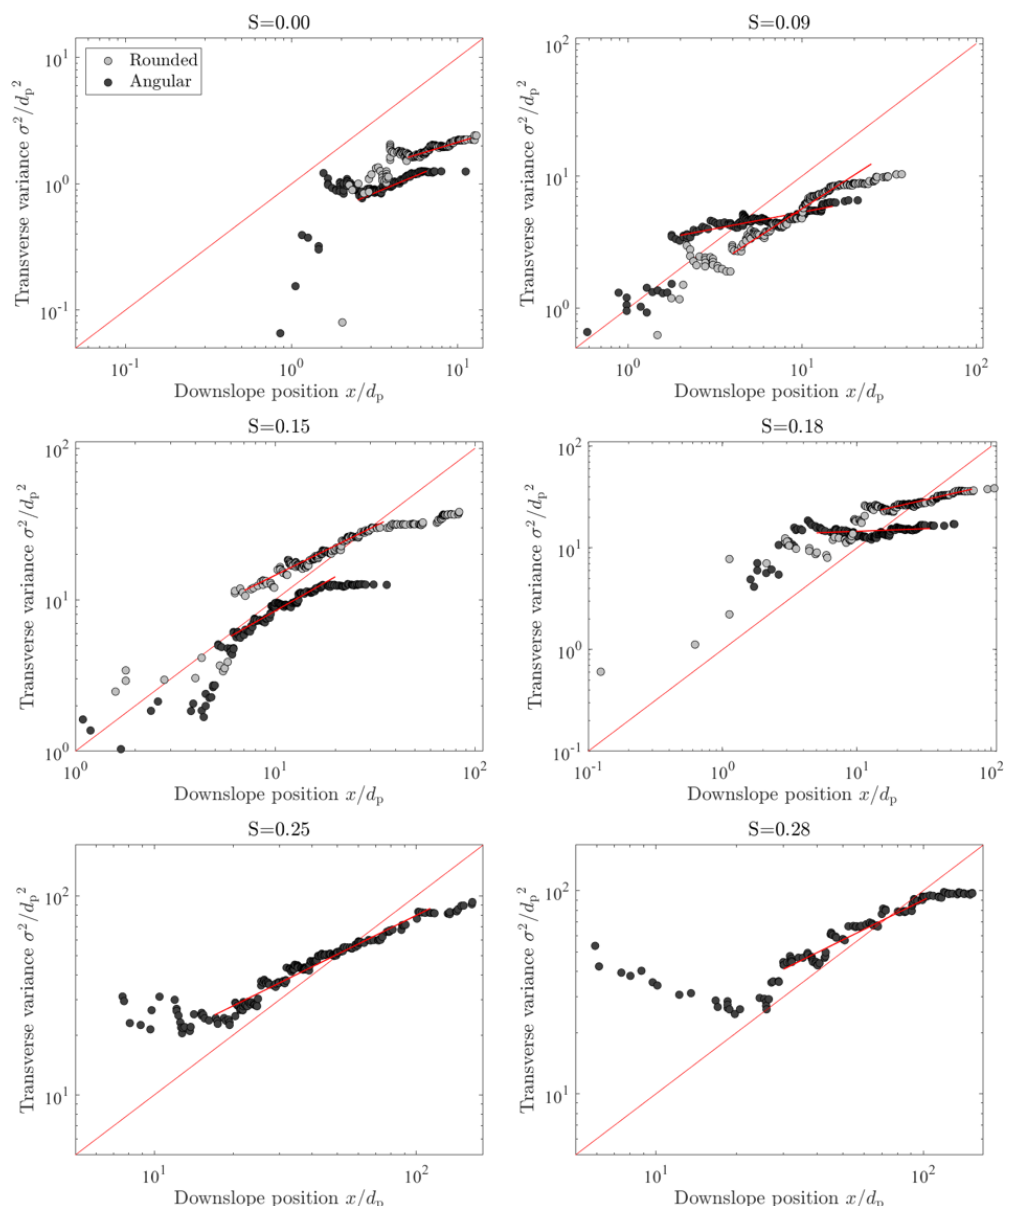
Figure 13. Plots in log–log space of transverse position variance σ 2 for angular (dark gray) and rounded (medium gray) particles as a function of downslope position x . Values are normalized by the average particle diameter (1cm). A line of slope 1 is plotted as a reference. The main bodies of data plotted are fit with power functions depicted in red to illustrate the difference in diffusion behavior. Tails of the data plotted are not included in the fit as these variance values are distorted by low sample numbers, at small downslope positions, or truncation of data, at larger downslope